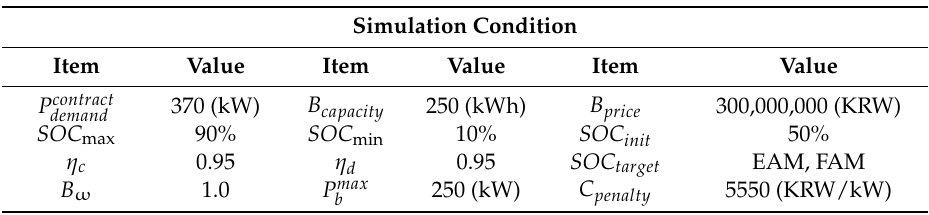
Table 1. Simulation parameters for battery energy storage system (BESS) scheduling and real-time control scheme (RTCS) for the sample case.